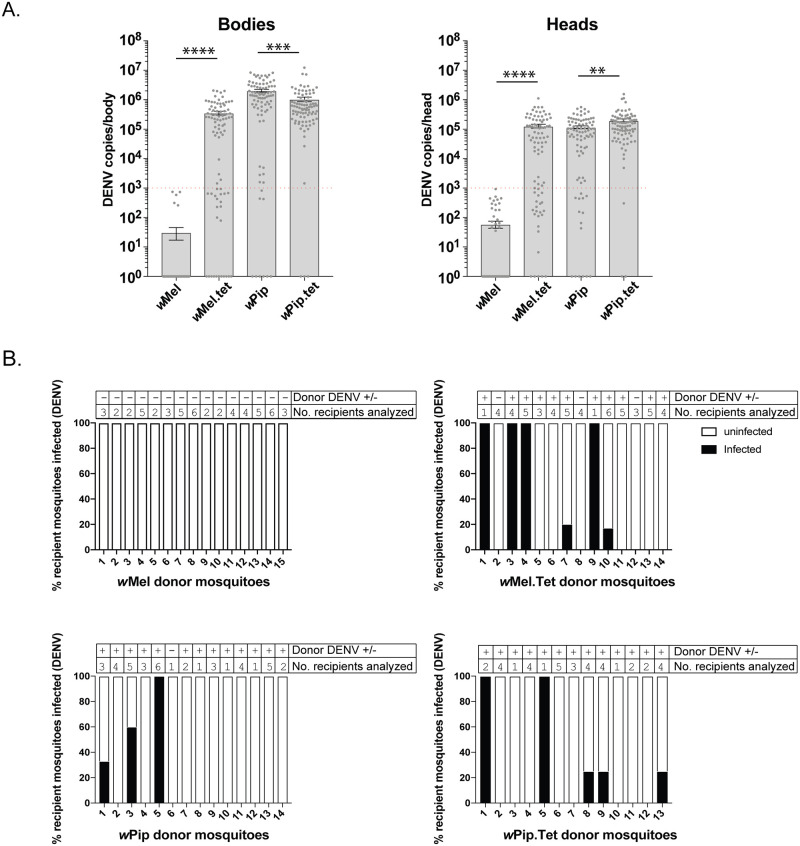
wPip does not restrict DENV replication, dissemination or transmission in Ae. aegypti following an infectious blood meal.(A) Seven-day old female mosquitoes were fed a blood meal containing DENV-3 (6.6 x 106 TCID50/ml) and incubated for 15 days. DENV genome copies were determined by qRT-PCR for each body as a measure of infection, and for each head as a measure of viral dissemination. Data are the mean viral genome copies per mosquito body or head ± SEM, with individual data points overlaid, and are representative of 3 independent experiments. Statistical analyses were performed using a Mann-Whitney test where ** p < 0.01, ***p < 0.001, ****p < 0.0001. Red line indicates LOD95 of the qRT-PCR reaction (103 DENV copies). Zero values have been plotted as 100 (1) to allow visualization on the log10 scale (B). At 14 d.p.i., saliva from 15 mosquitoes/line from (A) was collected (donor mosquitoes) and each saliva sample injected into 6 wMel.Tet mosquitoes (recipients) to determine whether the blood-fed mosquitoes were producing infectious virus. DENV genome copies in entire recipient mosquitoes were determined as in (A) and mosquitoes with DENV values above LOD95 were scored positive. Columns represent mosquitoes from a single donor, where black indicates the % recipients infected with DENV from a single donor mosquito. White is uninfected. Number of recipients analyzed from each donor, and whether the donor body was positive (+) or negative (-) for DENV are indicated above the columns.